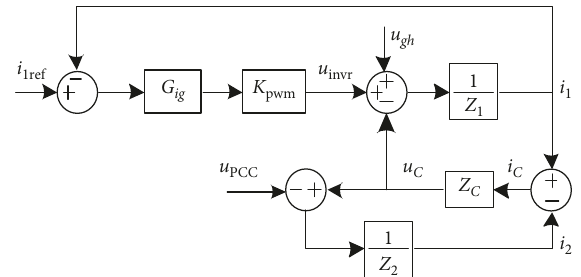
Figure 2: Current control block diagram of the grid-side converter.